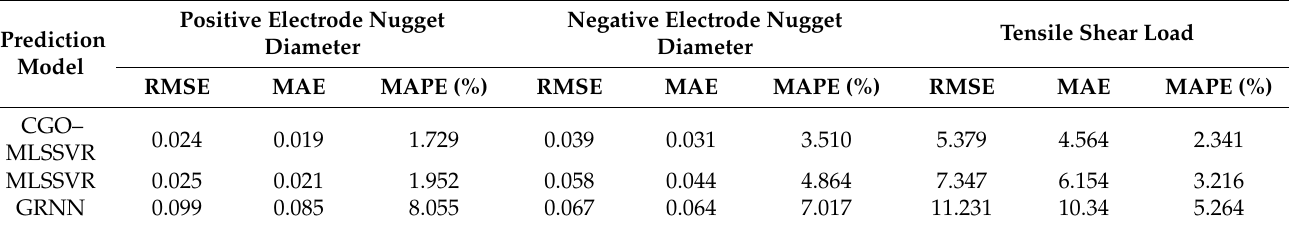
Table 10. Comparison results for different